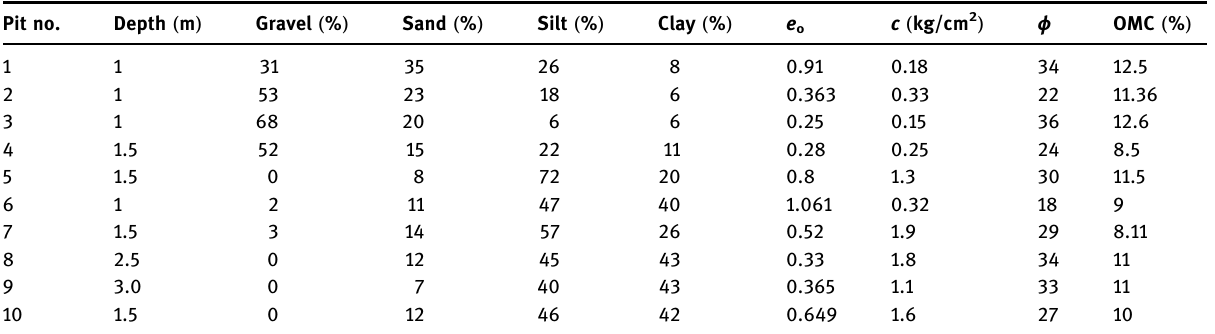
Table 1: Examples of various soil properties for Kirkuk city Pit